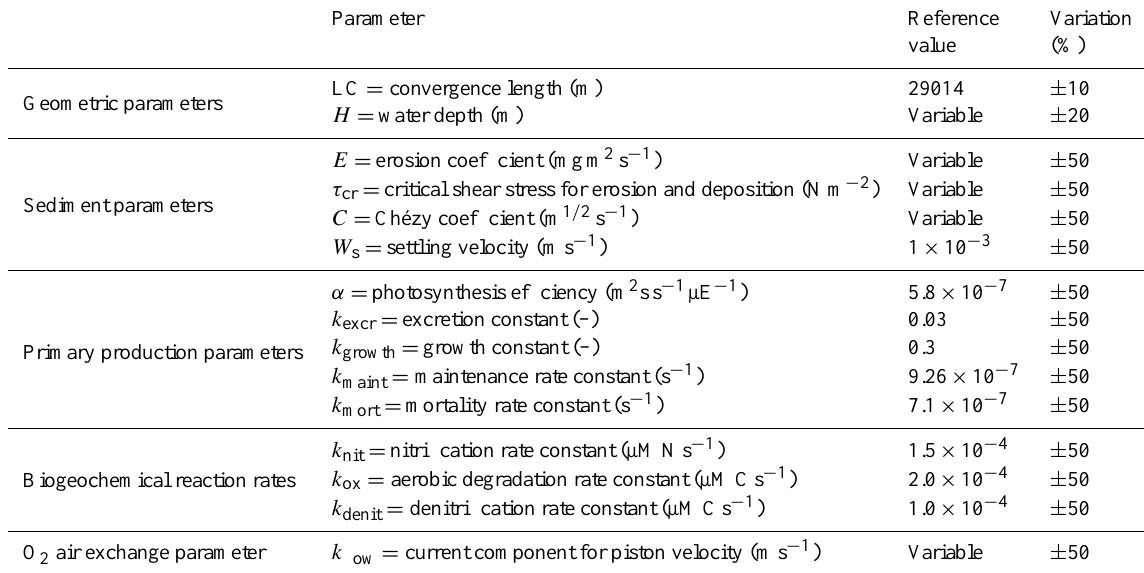
Table 7. List of parameter values for the reference case and percentage of variation applied to perform the sensitivity